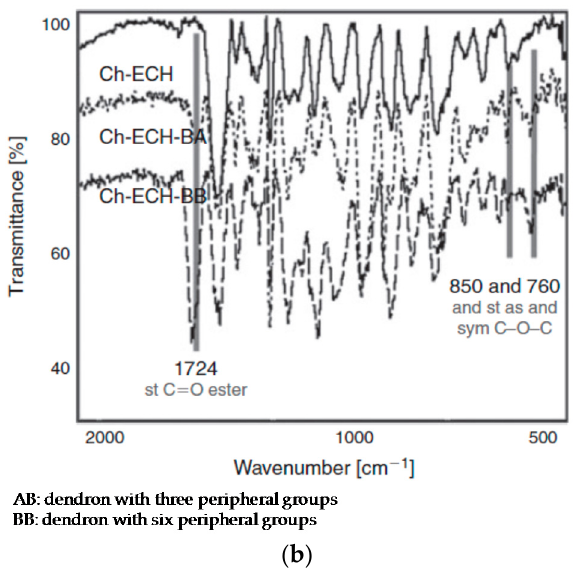
Figure 5. Synthetic route of dendronized microbeads ( a ); FT-IR spectra of dendronized microbeads ( b ). Reproduced from Ana Agustina Aldana et al. [14].